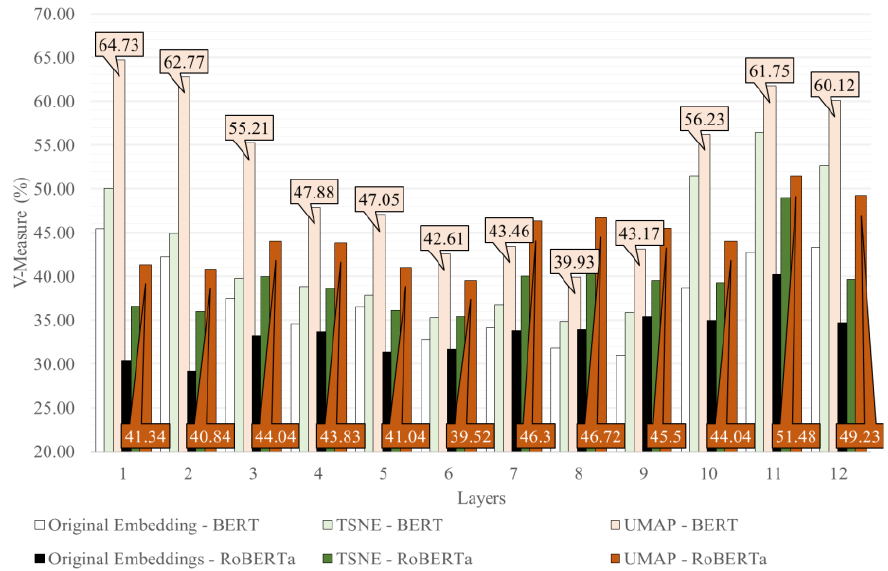
Figure 3. Original embeddings mean V-measure comparison with the results when TSNE and UMAP are used, for BERT (three left columns of the group, represented by light colors) and RoBERTa (three right columns of the group, represented with darker colors) models, according to the examined layer.